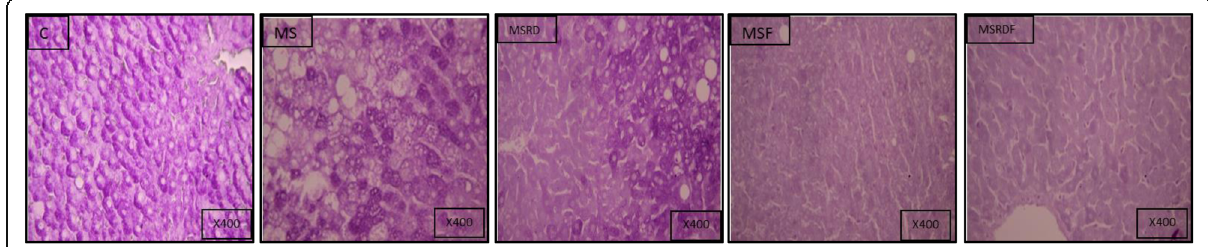
Fig. 9 Liver tissue photomicrograph of the five study groups after 12 weeks (PAS). C control group, MS untreated metabolic syndrome group, MSRD metabolic syndrome group reverted to regular rat chow, MSF metabolic syndrome group on alternate day fasting, MSRDF metabolic syndrome group reverted to regular rat chow and on alternate day